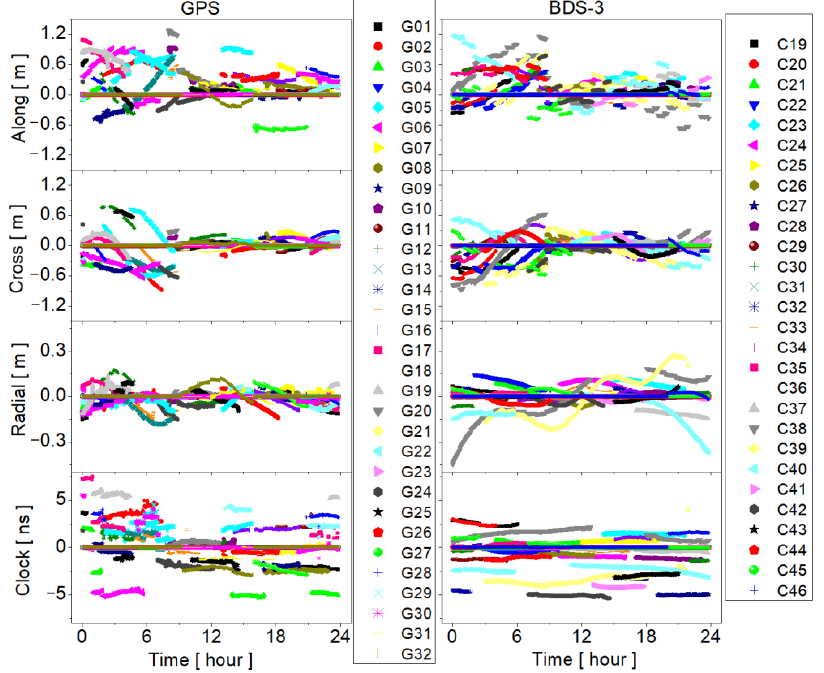
Figure 4. Figure 4. Satellite orbit and clock error time series of PPP-B2b products in MJDN 59100 (9 September 82020).